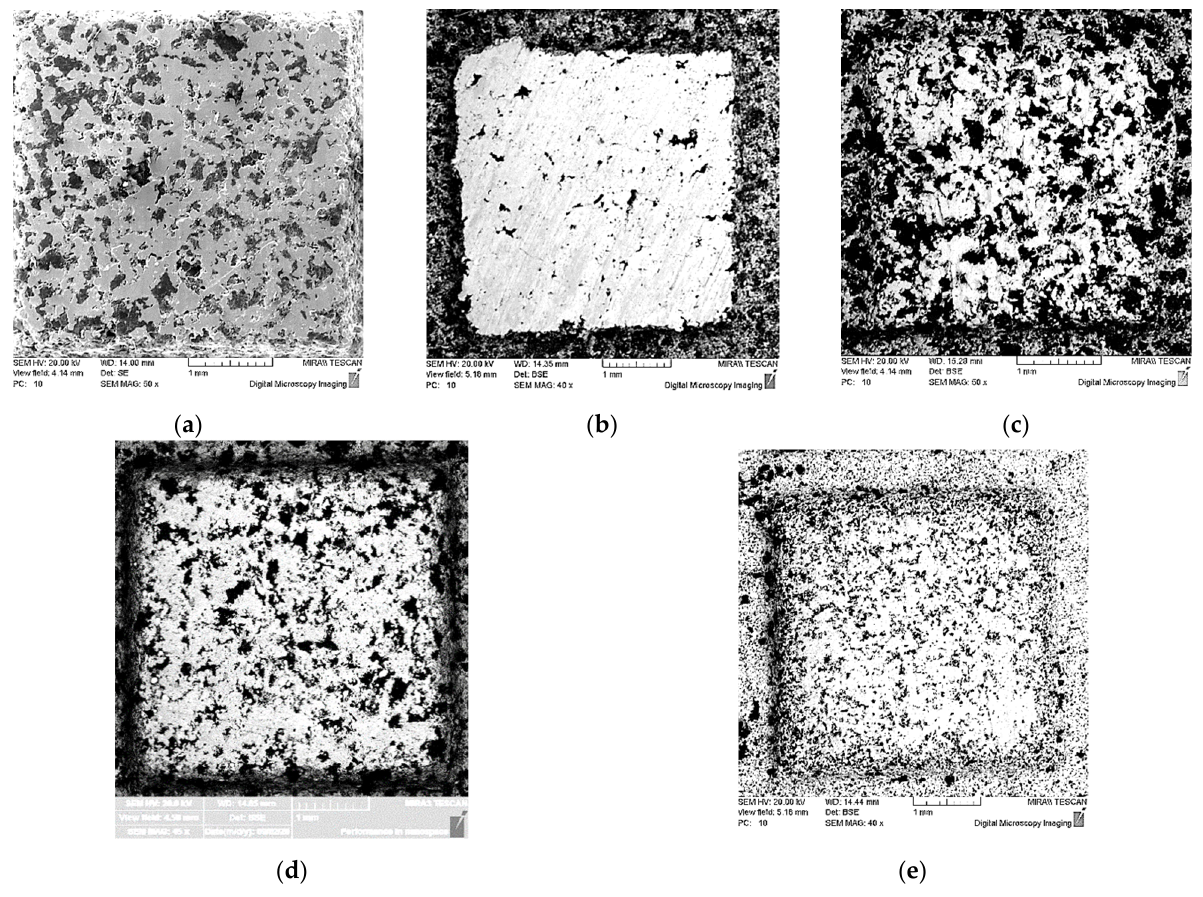
Figure 4. Morphology of the friction surface of the: ( a ) basic material; with powder additives ( b ) SiC; ( c ) Ti-46Al-8Cr; ( d ) 2 wt.% TiO 2 ; ( e ) 5 wt.% TiO 2 .